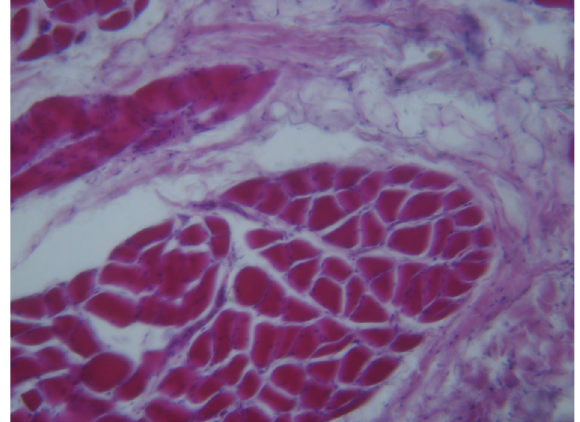
Figure 2. Microstructure of a lip tissue sample before processing with the ferment preparation Protepsin, magn.